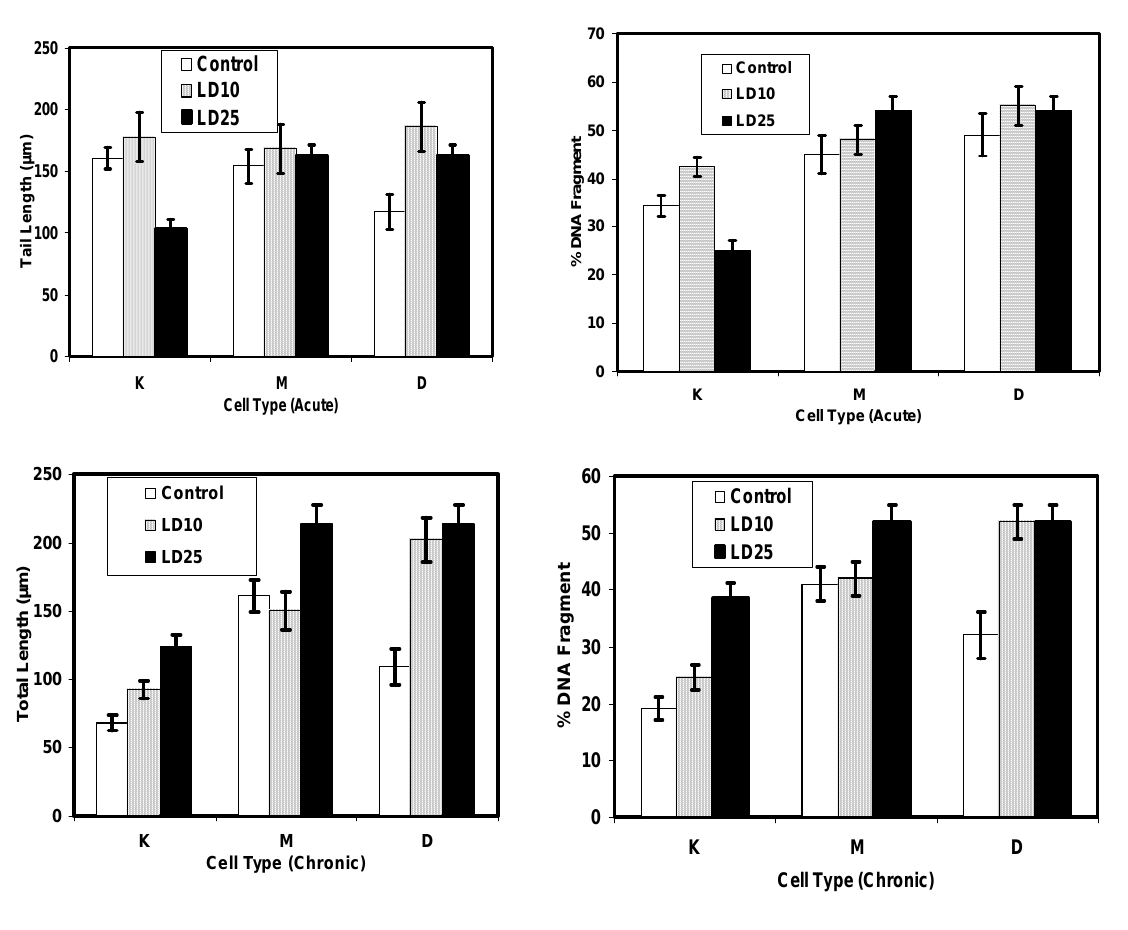
Fig. 2 : Percentages of DNA fragmentation and lengths of comet tail in acutely and chronically exposed keratinocytes (K), melanocytes (M), and dendritic cells (D) at LD